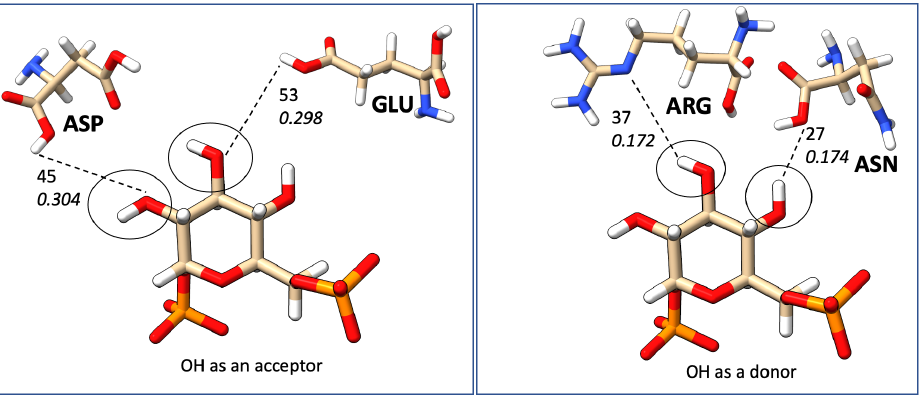
Figure 13. Frequent HBs interactions between the O–H ligand functional group and amino acid residues; the top numerical value mentions the number of HBs and the bottom value represents the average strength in mDyn/Å from database B.